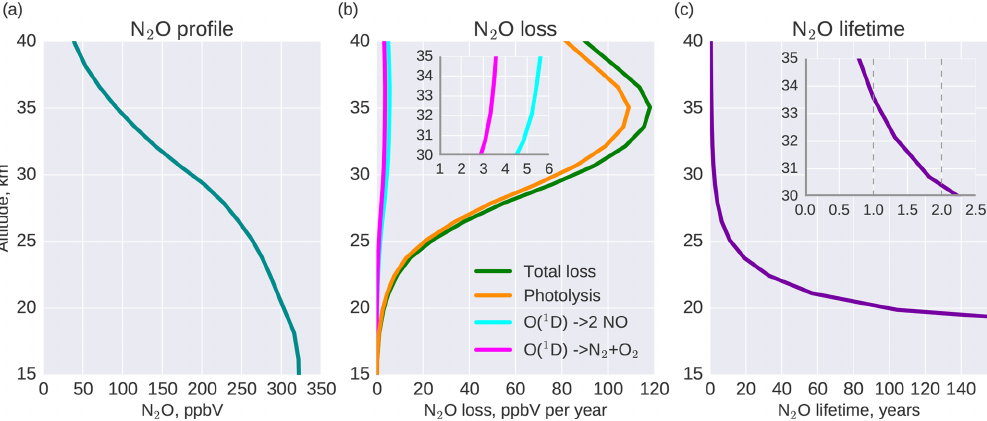
Figure 7. Average profiles of (a) N 2 O (ppbV), (b) N 2 O loss (ppbVyear − 1 ), and (c) N 2 O lifetime (years) from TOMCAT for the period 2004–2012. Colour coding in panel (b) indicates the source of N 2 O loss: total loss – green; loss via photolysis Reaction (R7) – orange; loss via oxidation with NO x production Reaction (R8a) – turquoise; loss via oxidation without NO x production Reaction (R8b) – magenta.